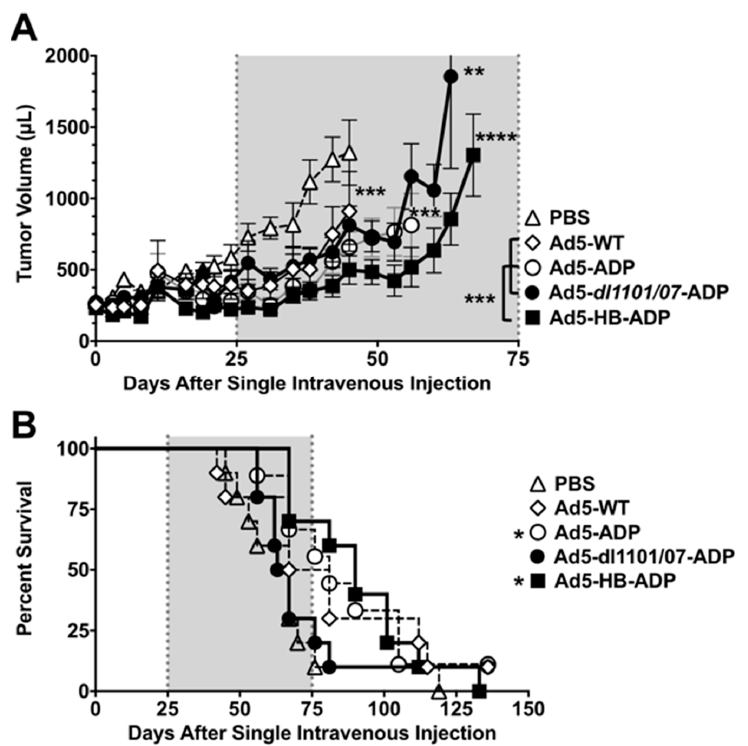
Figure 3. Anticancer activity of Ad5 viruses after intravenous injection. Groups of 9–10 hamsters with subcutaneous HaK tumors were injected a single time with 1.5 × 10 11 vp of the indicated viruses and tumor sizes were measured. ( A ) Tumor size. Tumor dimensions were measured with calipers and tumor volume was calculated as width 2 × length × 1/2. The data are shown as mean ± standard error (SE). Tumor size statistics were calculated by a paired repeated measures T test between groups. Asterisks next to lines show significance between the group and the PBS group. Asterisks to the left of the legend with brackets represent the significant difference between Ad5-HB-ADP and other viral groups; ( B ) Effect of a single intravenous injection on survival. An animal lost survival when their tumor exceeded 2000 µL. Kaplan–Meier survival curves were analyzed by Log-rank (Mantel–Cox) test. * p < 0.05, ** p < 0.01, *** p < 0.001, **** p < 0.0001.